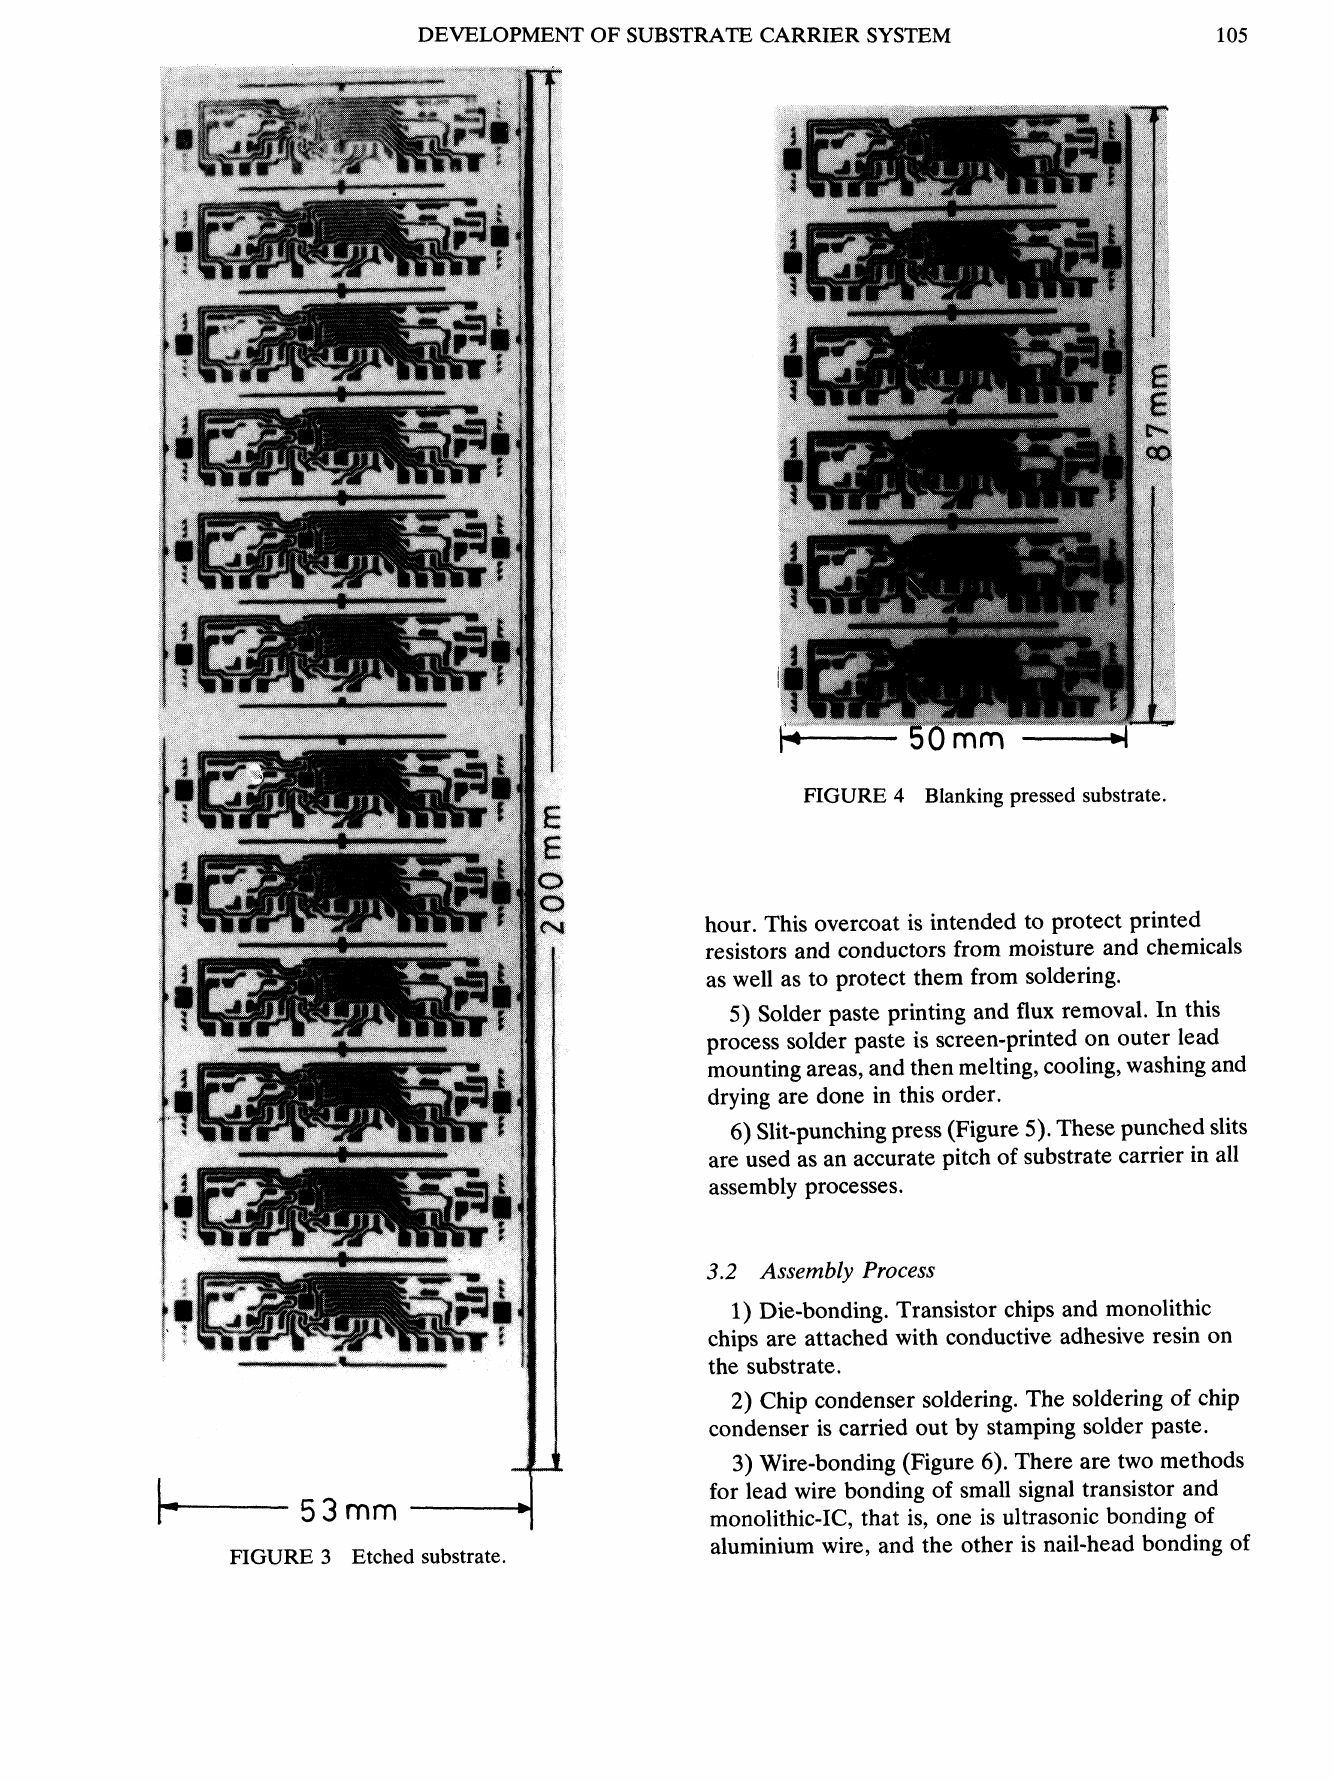
FIGURE 3 Etched substrate.